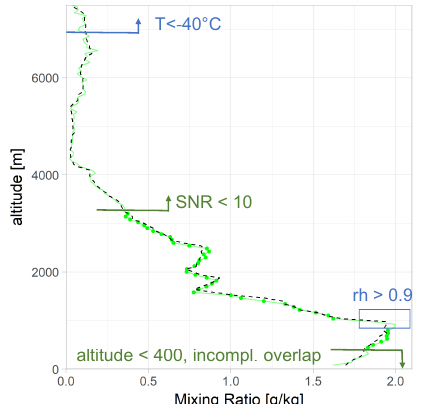
Figure 1. Exemplary lidar profile used for calibration (20 February 2018). Bins used for calibration ( z i ) are highlighted with green points. Conditions under which heights are excluded from calibration as in Table 1 due to deficiencies in lidar (green) or radiosonde data (blue) are marked.